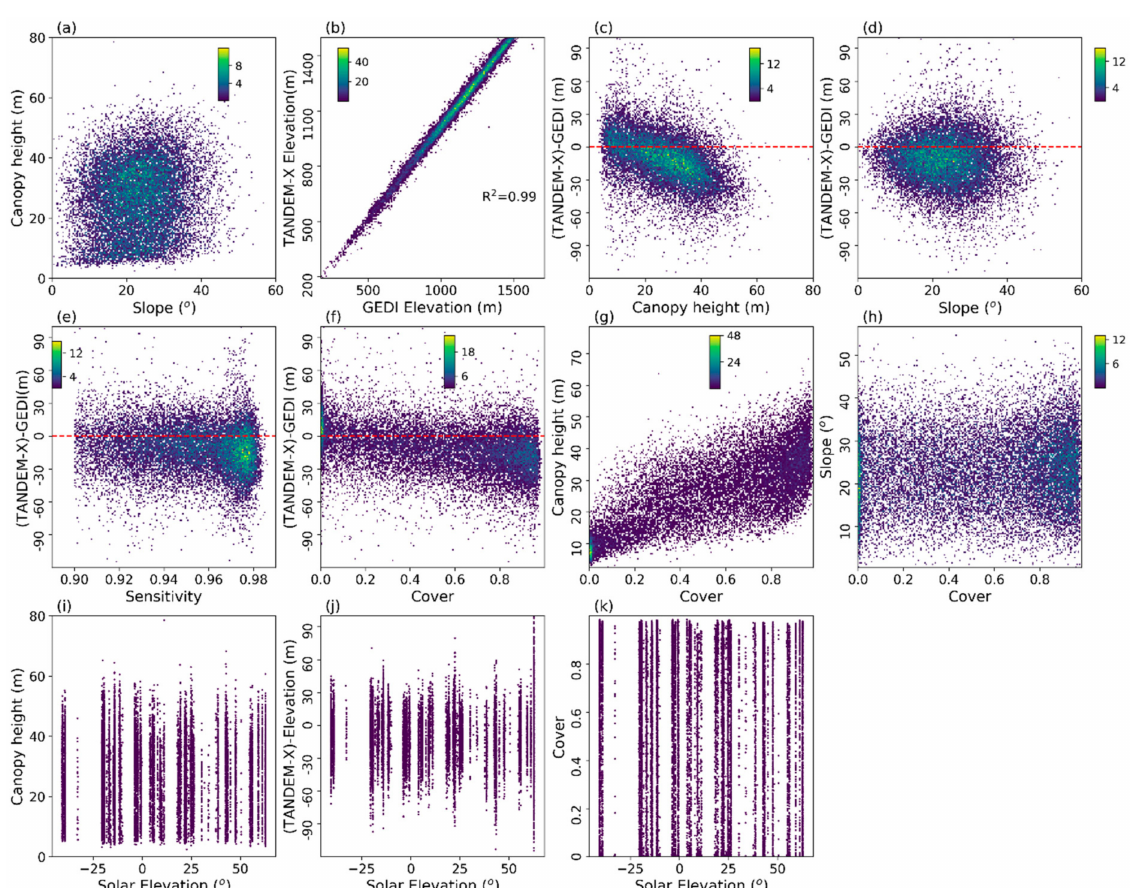
Figure 3. Canopy height data (rh 100 in L2A product) as a function of ( a ) slope derived from 1 arc-second Shuttle Radar Topography Mission (SRTM) elevation. ( b ) TanDEM-X ground elevation as a function of GEDI-derived ground elevation. Difference in elevation values between TanDEM-X and GEDI (labelled (TANDEM-X)-GEDI) as a function of ( c ) canopy height, ( d ) slope, ( e ) sensitivity and ( f ) canopy cover. ( g ) Canopy height and ( h ) Slope as a function of canopy cover. ( i ) Canopy height, ( j ) Difference in elevation values between TanDEM-X and GEDI and ( k ) canopy cover as a function of solar elevation, with negative values indicating night-time. Outlier values of TanDEM-X and GEDI differences are as large as 300 m: therefore for ( c – j ), a small number of positive outlier elevation values are not shown. The upper 2 rows (Subplots ( a – h )) are density scatter plots, with colours indicating the number of points per